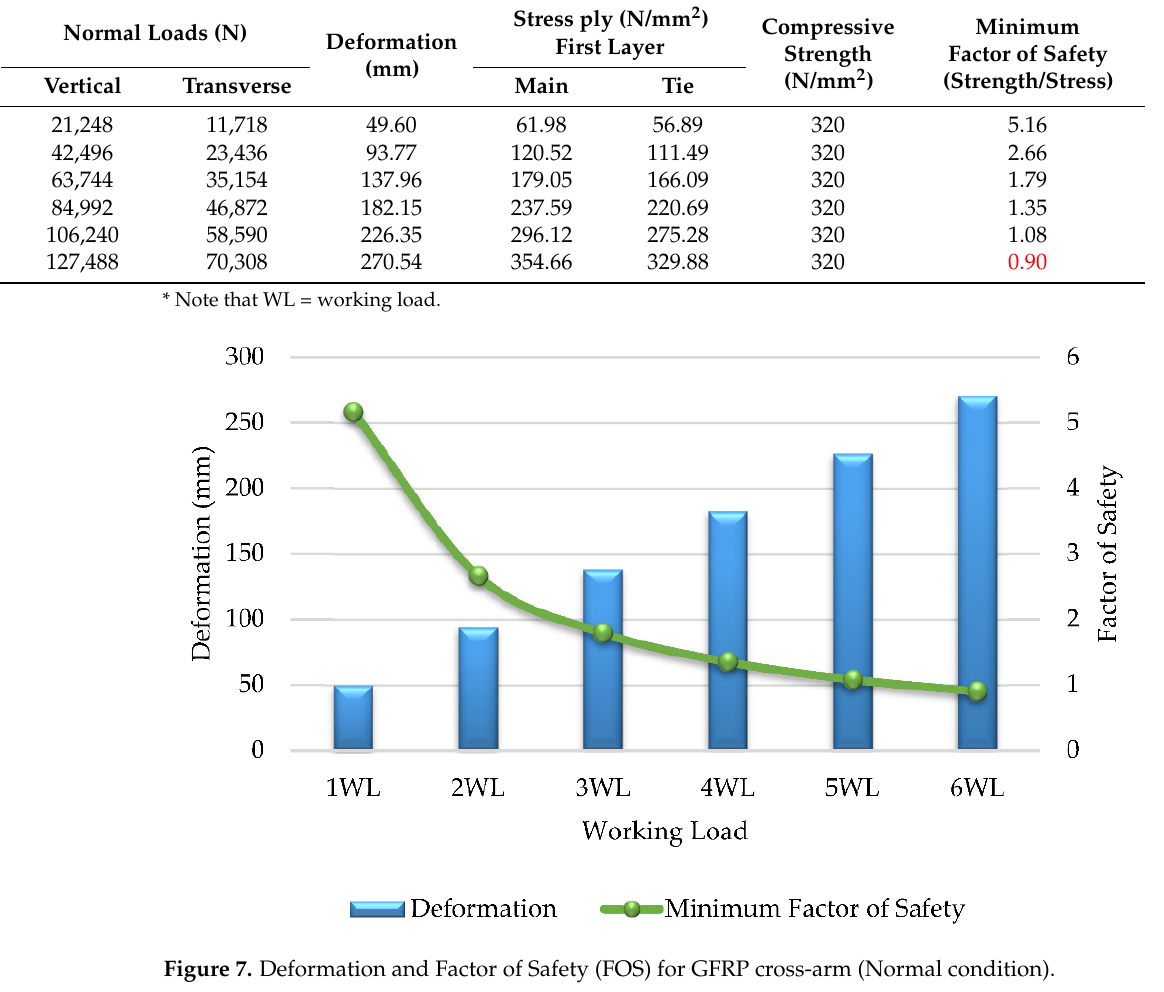
Table 4. Deformation, stress ply, compressive strength and factor of safety of GFRP cross-arm for normal condition.